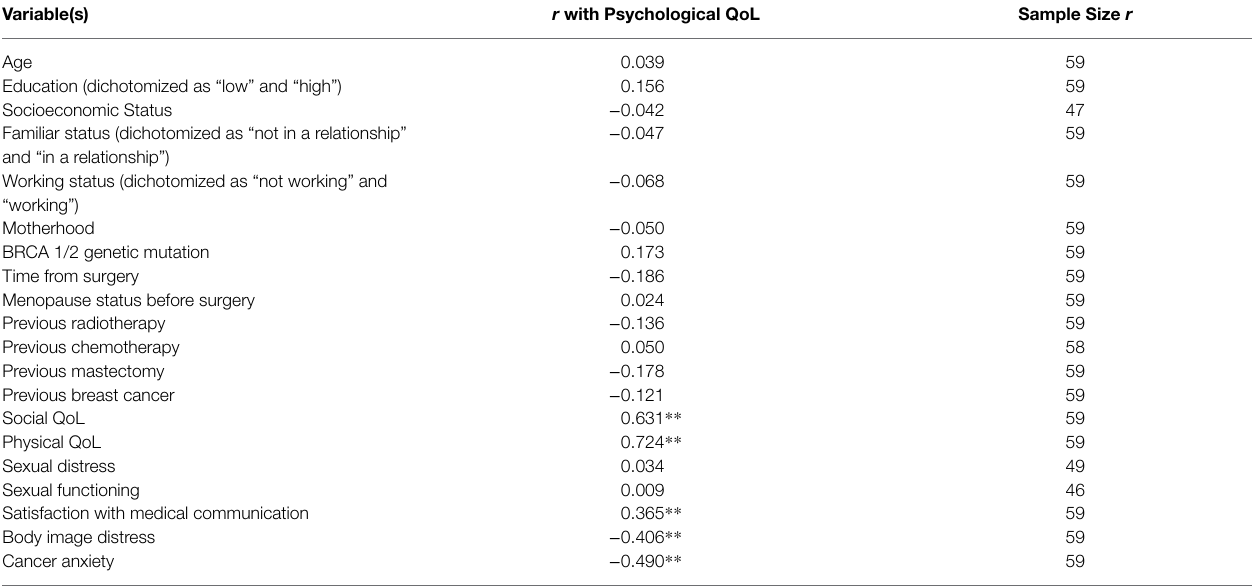
TABLE 2 | Zero-order correlations between post-surgery psychological Quality of Life (QoL) and all variables of interest ( N = 59).